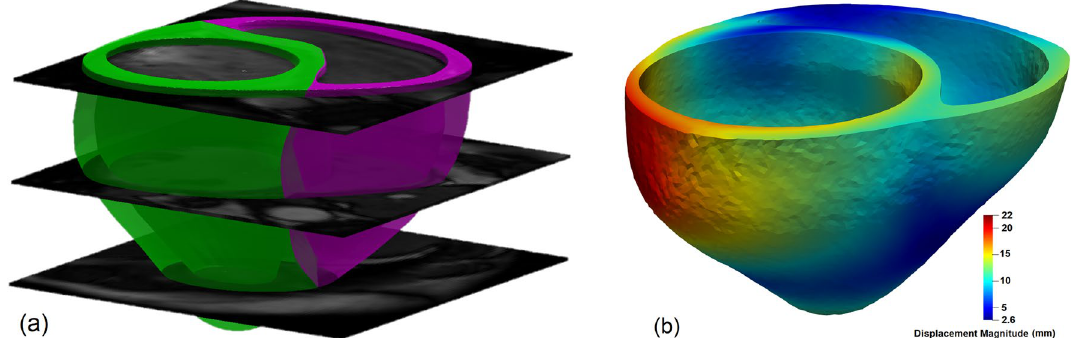
Figure 5. Application of the ML model to human heart: ( a ) anatomy reconstruction at ED using CMR scans ( b ) a representative displacement field generated in the inverse FE